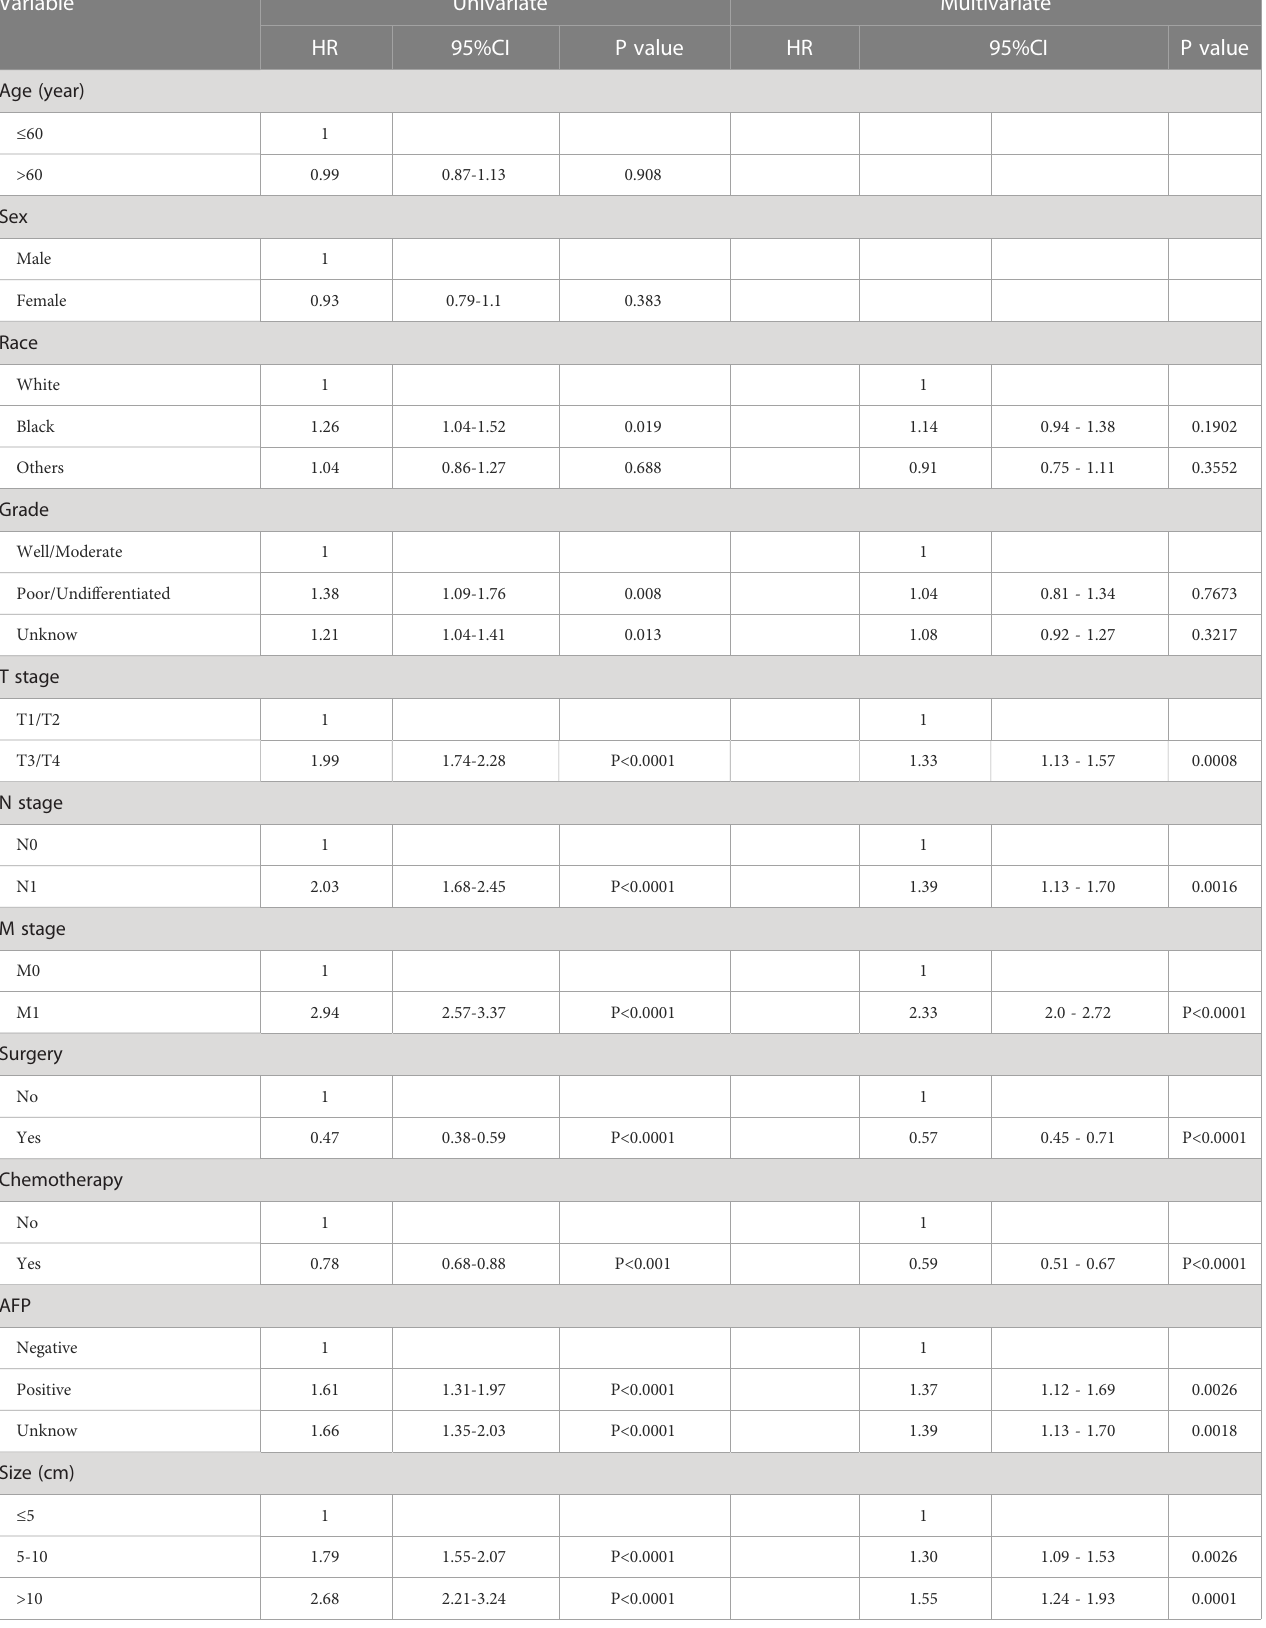
TABLE 2 Univariate and multivariate analyses of the clinicopathological parameters using the SEER training